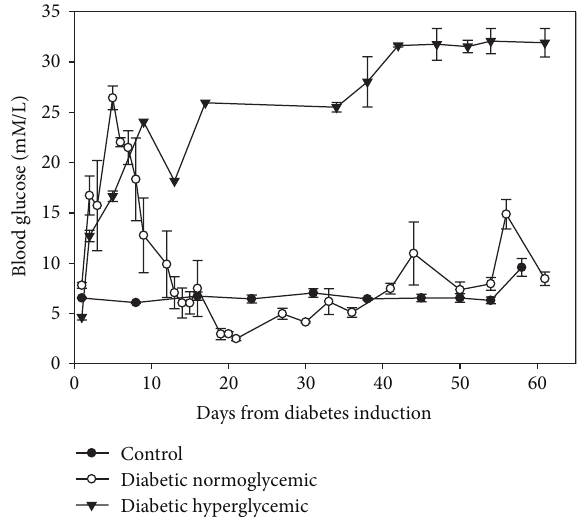
Figure 7: Blood glucose levels of STZ-treated DA rats. Diabetes was induced in DA rats by a STZ injection while 3 control animals were injected with vehicle. Blood glucose levels increased rapidly in the STZ-treated rats, both diabetic normoglycemic (DN) and diabetichyperglycemic(DH).Intheinsulintreatedrats(DNgroup), the blood glucose returned to normal values by day 12 (diamond symbol) following the insulin pellet implantation. Blood glucose levels of control animals were constant at approximately